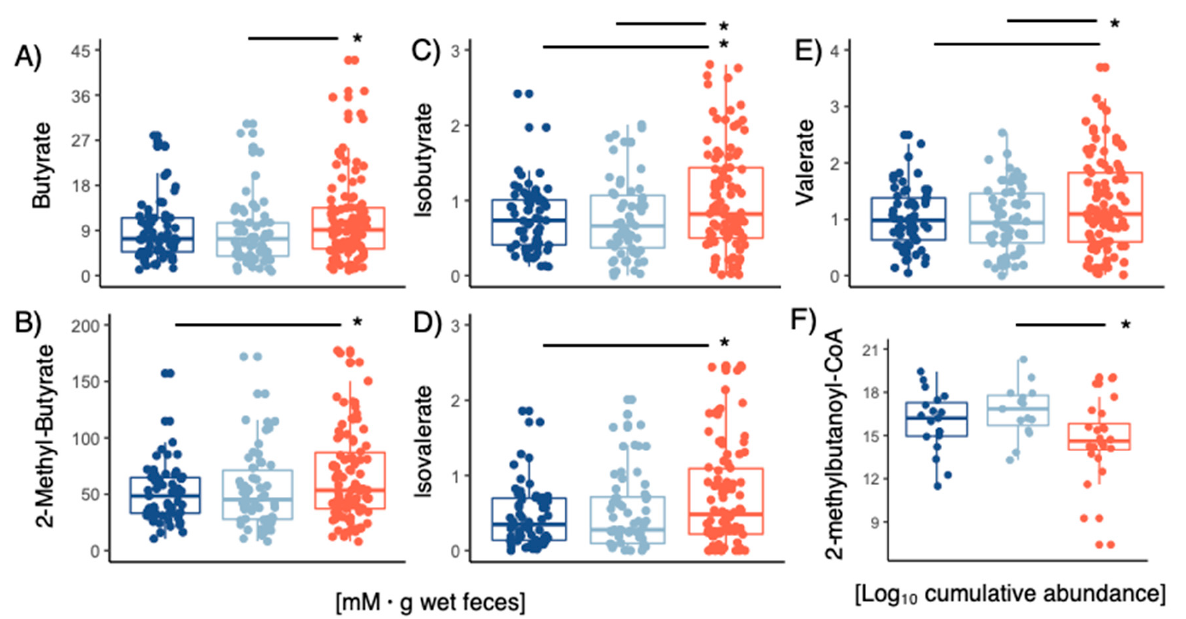
Figure 6. Concentrations of fecal ( A ) butyrate, ( B ) 2-methylbutyrate, ( C ) isobutyrate, ( D ) isovaler- ate, ( E ) valerate concentrations within the different LPD clusters. ( F ) Cumulative abundance 2- methylbutanoyl-CoA genes screened on metagenomes within LPD clusters. Stars show statistical level of significance (* p ≤